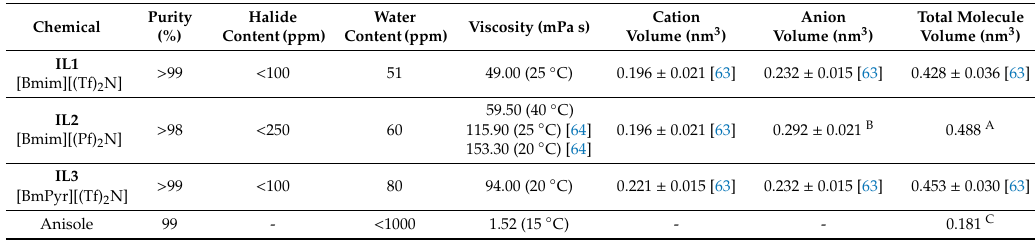
Table 1. Characteristics of the used chemicals for IL mixtures. Values were provided by the delivering companies, if not noted di ff erently by the addition of the literature sources at the specific